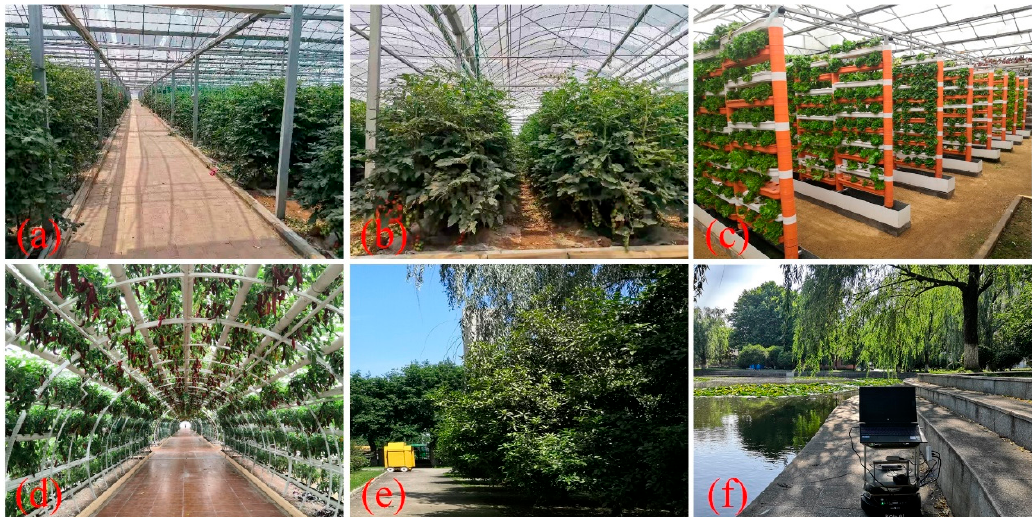
Figure 5. The complex and changeable experimental environments of each localization test. ( a – d )